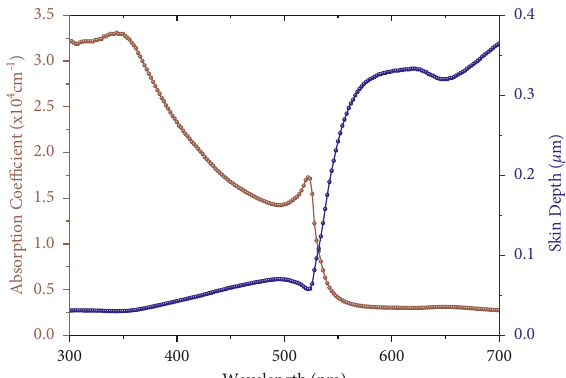
Figure 7: Refractive index and extinction coefficient of the MAPB thin film.